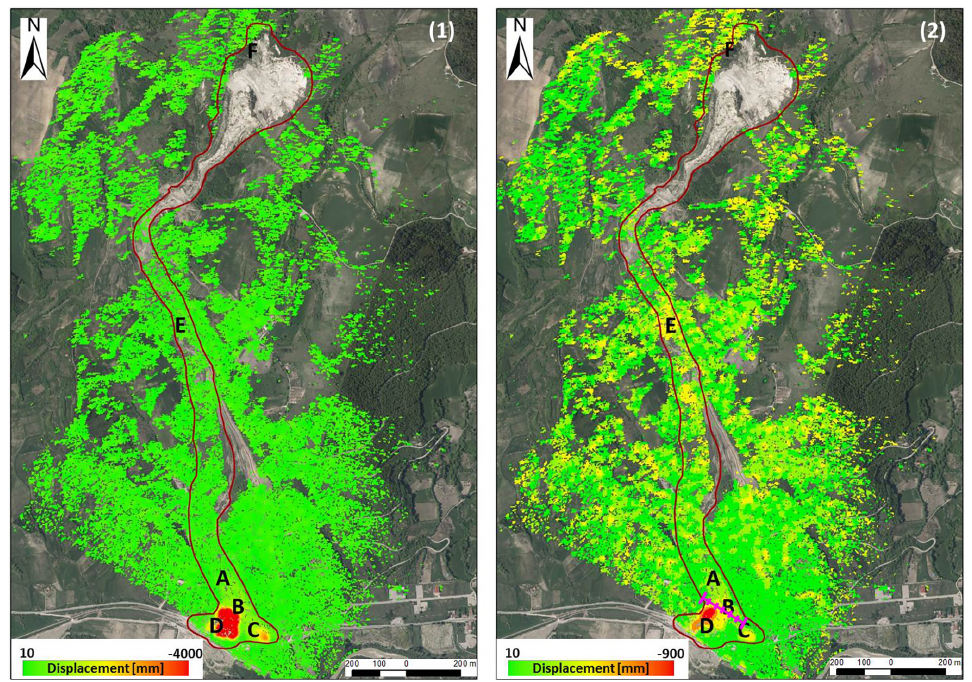
Figure 12. Monthly cumulated displacement maps: (1) in July 2010, the interferometric data show abundant stagnant water within the surface depressions, affecting sectors D and C; (2) during August 2010, the interferometric data show the efficiency of the realized cross trench (in pink – stabilization work no. 10 in Fig.